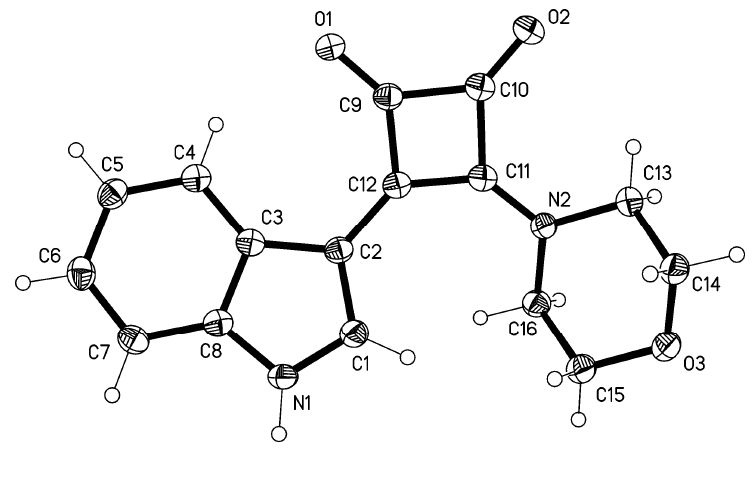
Figure 1. The molecule of compound 3 in the crystal. Ellipsoids represent 50% probability